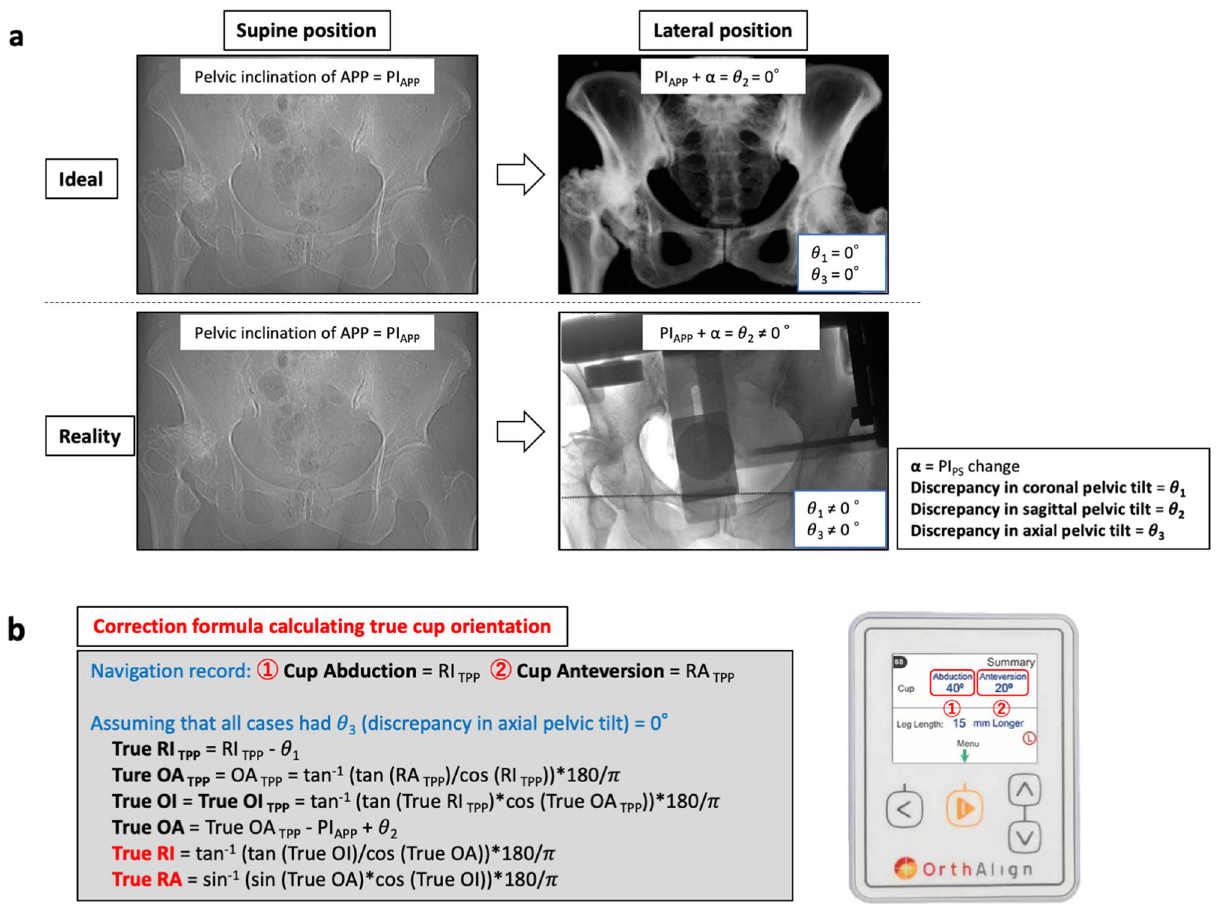
Figure 3. Correction formula calculating true cup orientation based on the discrepancy in pelvic tilt, as measured by TPP images. ( a ) Although the APP should ideally be parallel to the TPP, pelvic tilt discrepancies were observed in many cases in reality. ( b ) We created a correction formula to calculate the true cup orientation based on the pelvic tilt discrepancies (θ 1 and θ 2 ) measured by the TPP images. APP, anatomic pelvic plane; PI PS , pelvic inclination of plane formed by pubic symphysis and sacral promontory in supine or lateral position; RI, radiographic inclination; RA, radiographic anteversion; OI, operative inclination; OA, operative anteversion; TPP, table parallel plane; RI TPP , RI based on the TPP; RA TPP , RA based on the TPP; OI TPP , OI based on the TPP; OA TPP , OA based on the